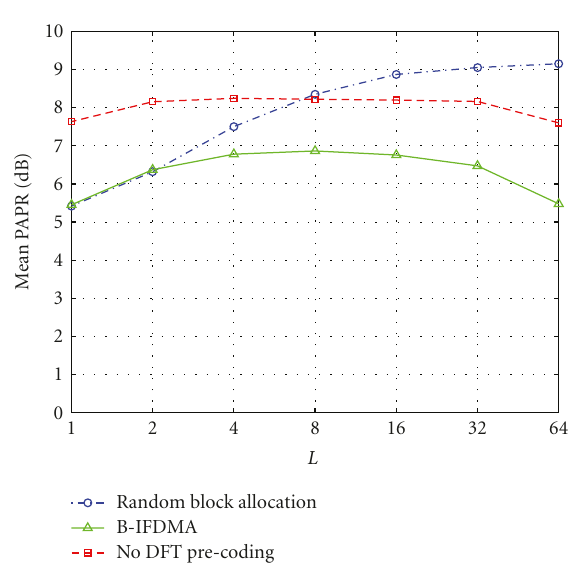
Figure 10: Mean PAPR of B-IFDMA transmit signals with Q = 64 as a function of number of blocks L compared to the corresponding schemes without DFT precoding and schemes with random allocation of the subcarrier